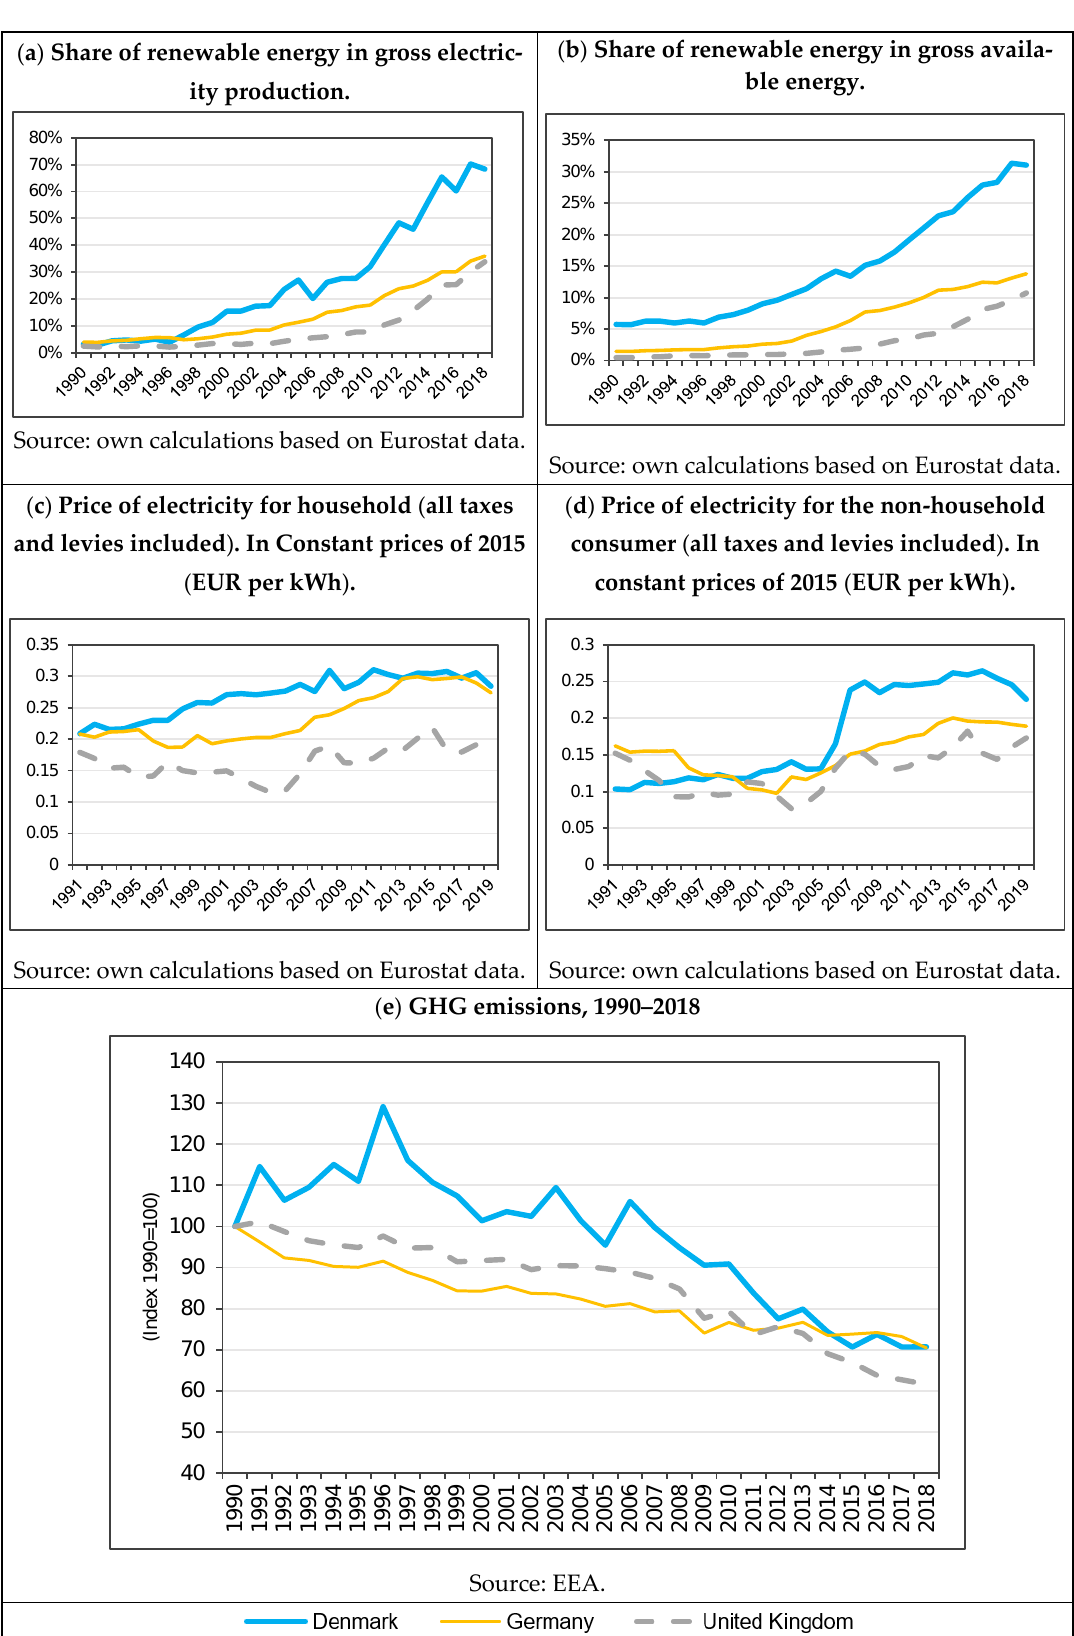
Figure 1. Evolution of variables related to the RE transition in Germany, Denmark, and the UK in 1990–2018.